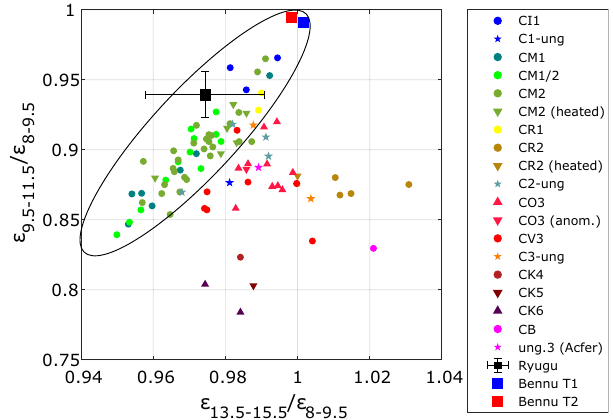
Fig. 4 Comparison of emissivity ratios derived from MARA data to emissivity ratios of chondrite thin sections and Bennu. Emissivity spectra of the meteorite samples are derived from inverted re fl ectance spectra of thin sections of carbonaceous chondrites. Black square with error bars shows the ratio of the estimated emissivity of Ryugu in the 8 – 9.5 µ m, 9.5 – 11.5 µ m, and the 13.5 – 15.5 µ m bands with error bars indicating the 25th and 75th percentile of the estimated band ratios. Inverted re fl ectance spectra of thin sections of various carbonaceous chondrites 44 and Bennu ’ s emissivity spectra, where T1 and T2 different spectral types of the surface 44 , are averaged within the MARA channels and weighted by the MARA instrument functions. The aqueously altered CM, CI, CR1 chondrites, Bennu and Ryugu form a common trend, from which the CV, CO, CR2, CB, and CK deviate systematically. Chondrites that were subjected to heating (downwards pointing triangles) do no vary signi fi cantly from the unheated chondrites of the same type. The ellipse is shown to guide the eye. Source data are provided as a Source Data fi